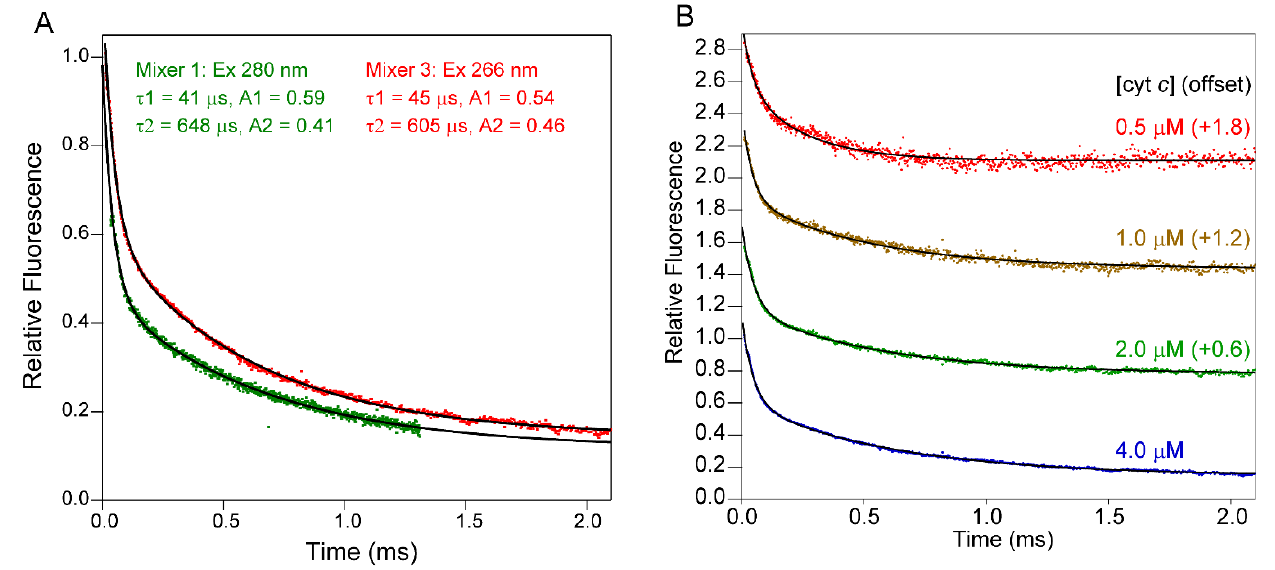
Figure 7. ( A ) Kinetics of refolding of acid-denatured cyt c (pH 2, salt-free) triggered by a jump to pH 4.5 (100 mM sodium acetate) recorded using Mixer 1 (green trace, 280 nm excitation) and Mixer 3 (red trace, 266 nm excitation). ( B ) Kinetics of refolding of cyt c (same conditions as in panel ( A )) at different protein concentrations, as